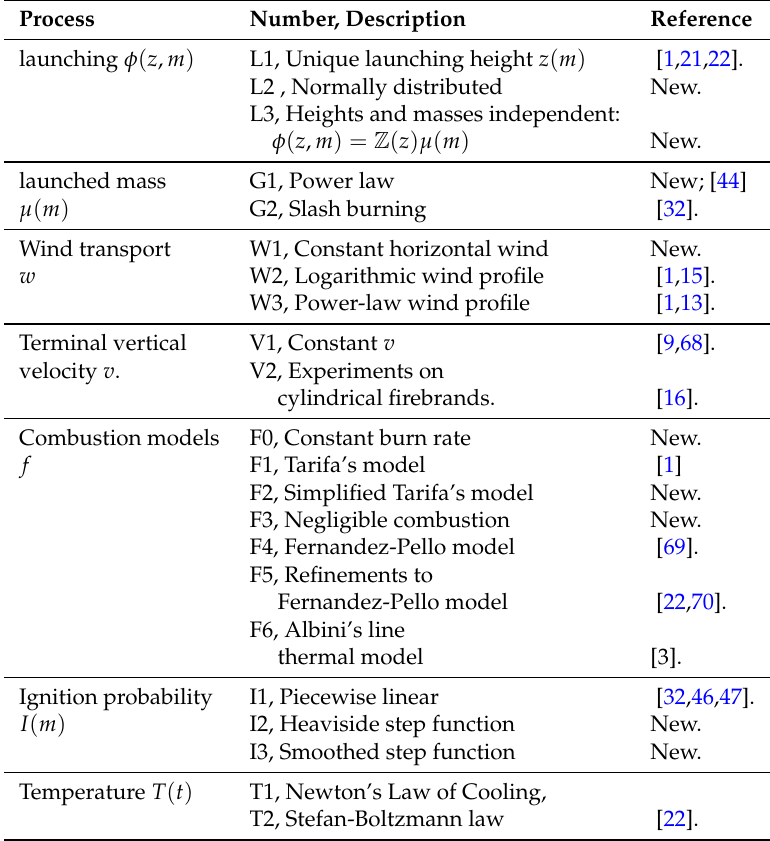
Table A1. Physical and empirical models for spotting